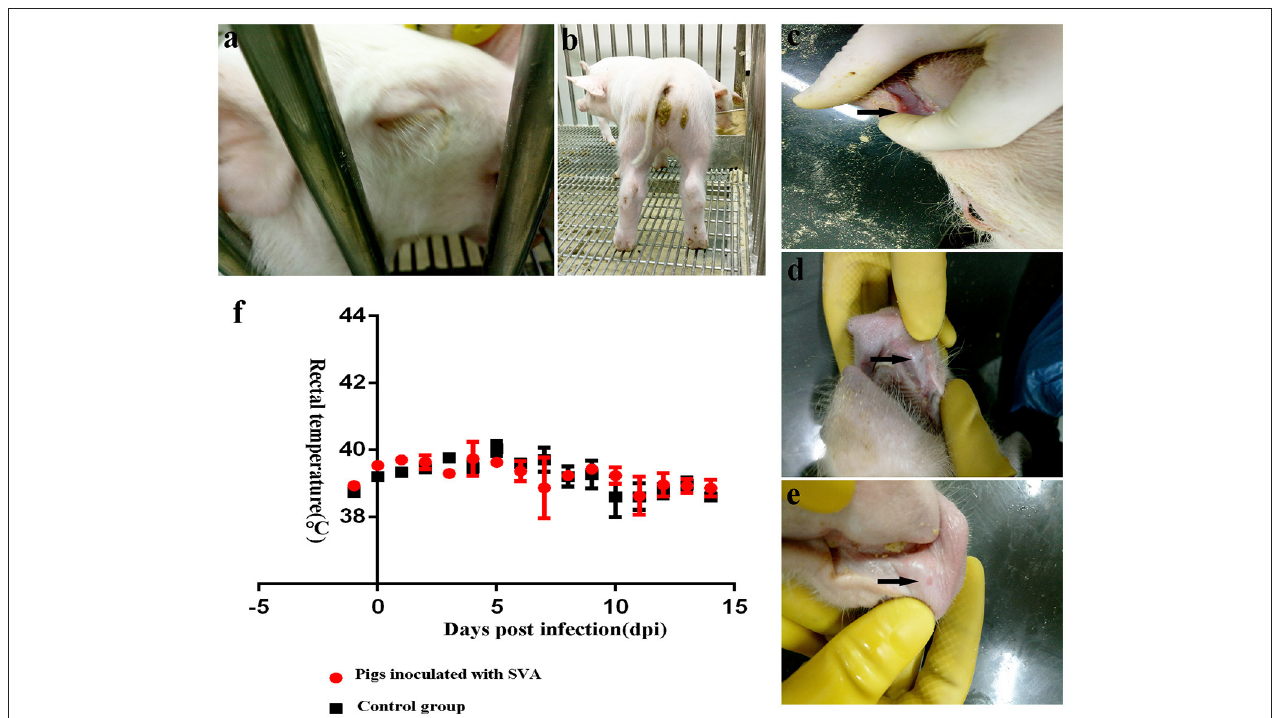
FIGURE 1 | Clinical signs of weaned pigs challenged with Senecavirus A (SVA) CH/FuJ/2017. (a) Lethargy was observed at 2 days post-infection (dpi). (b) Diarrhea caused by SVA infection was found at 3 dpi. (c–e) The development of SVA-induced vesicle on the oral mucosa (black arrow). Small fluid-filled vesicles were firstly observed at 3 dpi and rapidly ruptured and recovered. (f) The rectal temperature was monitored daily. Persistent high fever was not observed, and there was no significant difference in rectal temperature between challenged and unchallenged